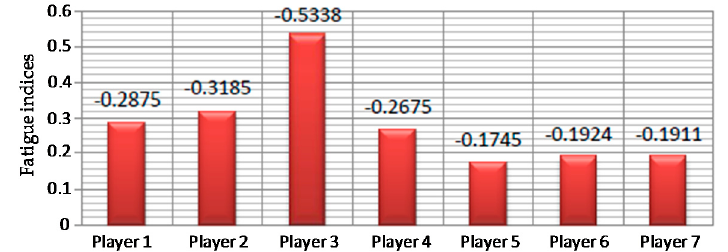
Figure 7. Fatigue indices in the vastus lateralis.